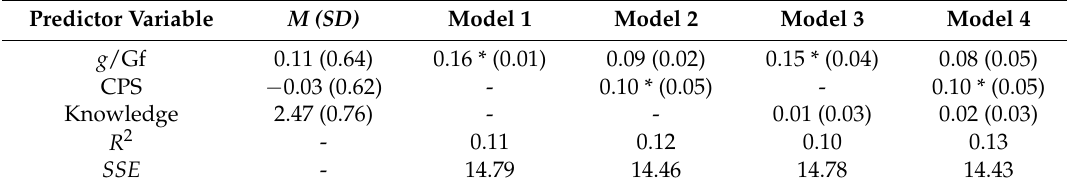
Table 5. Regression models for Job Zone 3 (DV: natural log median annual wages, ln).